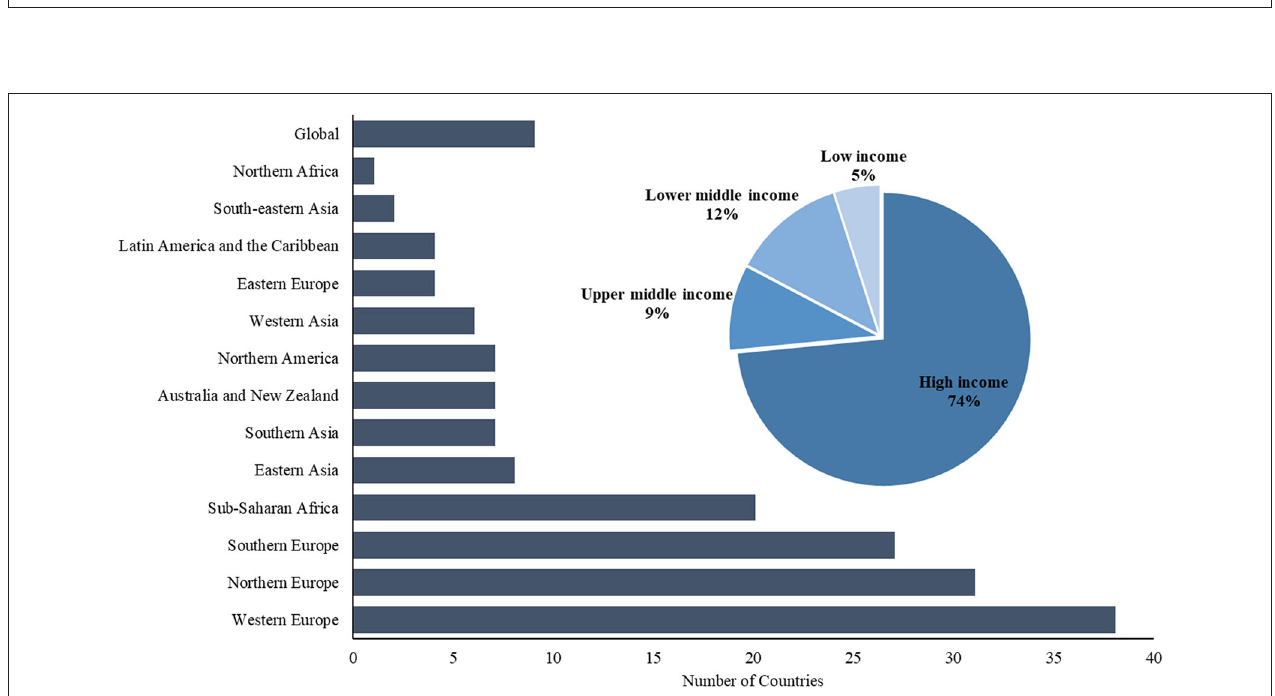
FIGURE 3 | Distribution of countries contributing data to included articles, by sub-region and income group. Sub-Region classification is based on the United Nations Statistics Division classification (UNSD, 2020). Income group classification is based on the World Bank’s 2020 fiscal year classification (World Bank Country Lending Groups, 2020). The x axis shows the number of countries that contributed data to the included studies from the sub-region shown. Studies were classified as global if they included data from > 36 countries.